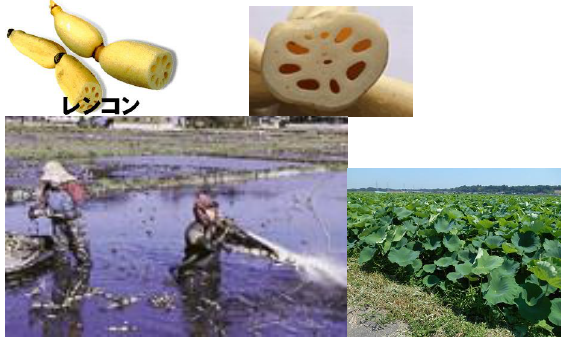
Figure 3. Lotus roots and its harvest in a lotus pond (Ministry of Agriculture, Forestry and Fisheries, 2016b)